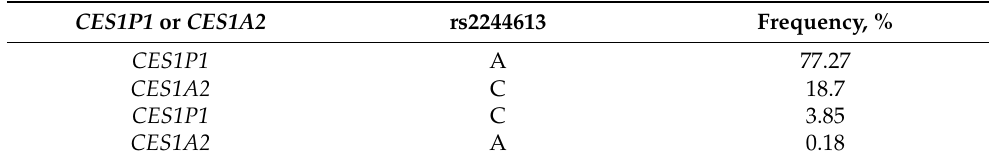
Table 2. Haplotypes of CES1 based on the rs2244613 genotype and presence of CES1P1 or CES1A2 .